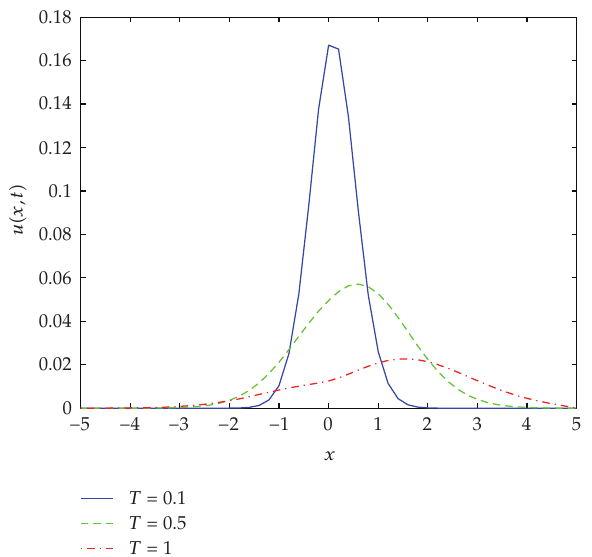
Figure 5: Numerical solutions for Example 5.3 with α (cid:7) 1 . 0 and μ (cid:7) 2 . 0 at di ff erent times T (cid:7) 0 . 1 , 0 . 5 , 1 . 0.